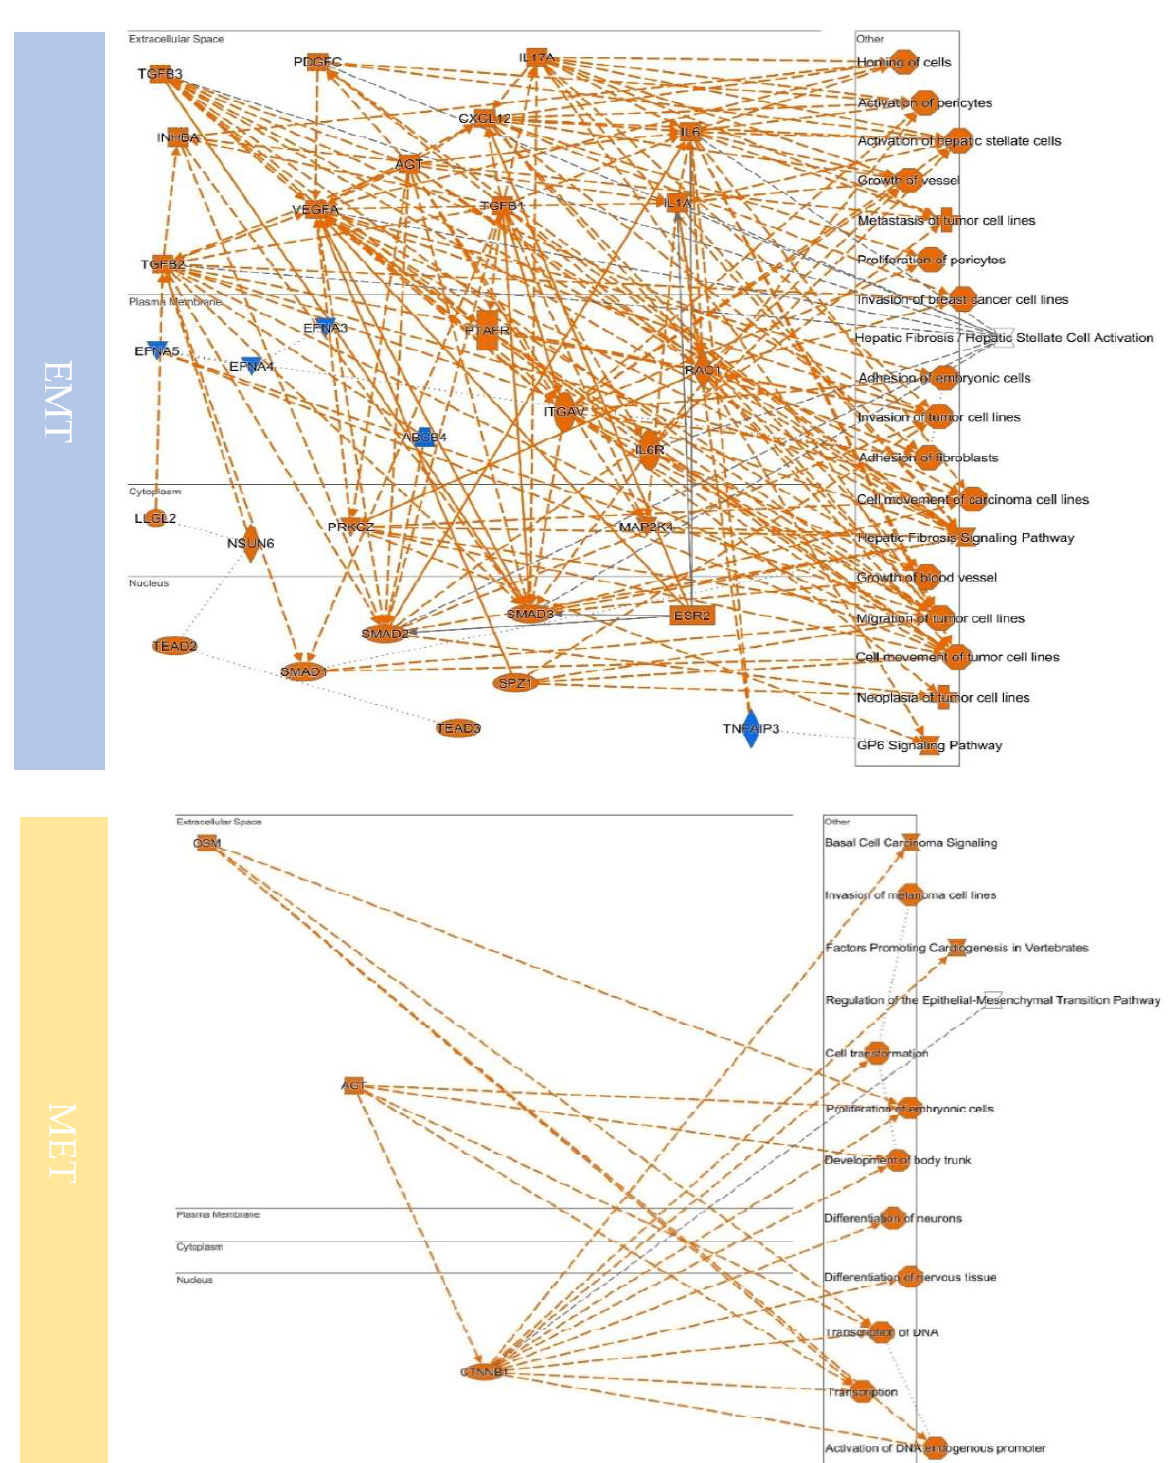
Figure 8. Simulated molecular network between EMT and MET. The simulation of molecular interactions between EMT or MET hallmarks and the related biological functions of participation was conducted through prediction methods, in which gene ontology is linked to cytoskeleton remodeling, metastasis, remodeling the microenvironment, and embryogenesis- related process. (MET- or EMT-related molecules were downloaded from GSEA datasets, and the analyzed interaction map results were output from the Ingenuity Pathway